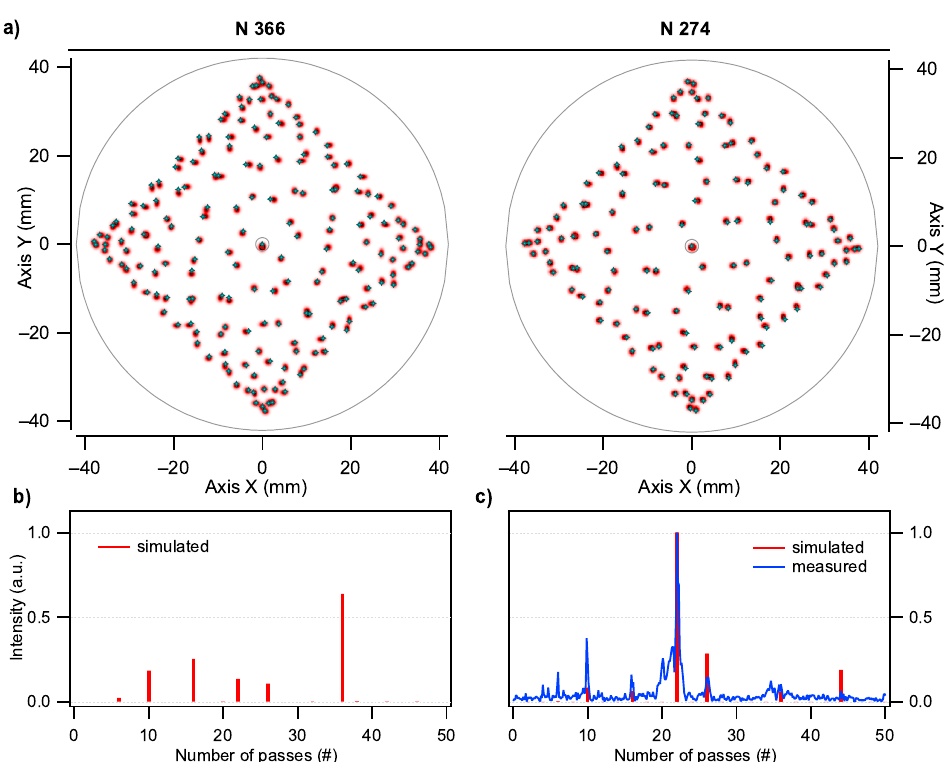
Figure 3. Reflection spot patterns of the MPC. ( a ) (stars) Paraxial (transfer-matrix based) and (dots) non-paraxial (ray tracing) spot simulations on the front MPC mirror (with coupling hole) for the N366 and N274 patterns. ( b ) Simulated interference fringes spectrum for the N366 pattern based on the paraxial propagation simulation. The fringe intensities are given in arbitrary units. The number of passes corresponds to the fringe generating length. ( c ) Simulated and measured interference fringe spectra for the N274 pattern. Both simulated spectra are normalized to the simulated fringe intensity at 22 passes. Similarly, the measured spectrum is normalized to the measured fringe intensity at 22